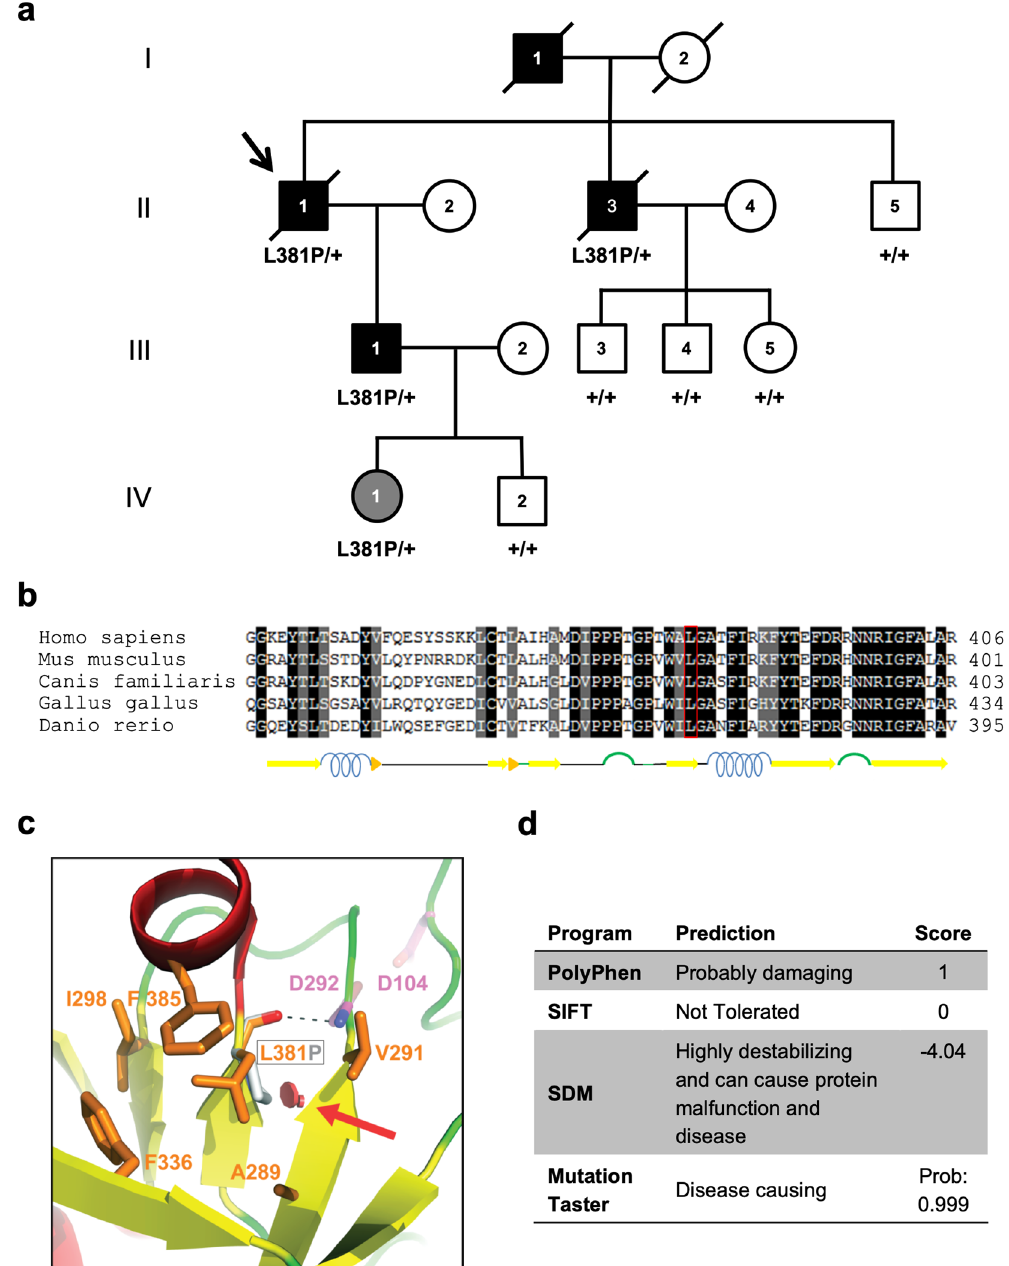
Figure 1. Identification of L381P renin variant in an ADTKD family. ( a ) Pedigree chart of the ADTKD family segregating the renin p.L381P variant. Index case (arrow): II-1. Black symbols denote clinically affected individuals, open symbols denote clinically unaffected individuals. Corresponding REN genotype is provided for each tested individual. ( b ) Alignment of renin sequence from human, mouse, dog, chicken and zebrafish performed with the Sequence Manipulation Suite 38 . Identical or similar residues are shown with a black and grey background respectively. Predicted secondary structure is shown below. ( c ) Detail of the human renin structure, shown in cartoon representation and colored by secondary structure (red: α -helices; yellow: β -strands; green: loops). L381 and nearby conserved hydrophobic residues (orange), as well as the two catalytic aspartates (magenta), are depicted as sticks; a red arrow indicates the steric clash (red discs) that would be introduced upon mutation of L381 to proline (grey stick). The main-chain hydrogen bond between L381 and D292 is represented by a dashed black line. The figure was made with PyMOL (Schrödinger LLC). ( d ) Predicted effect of the renin L381P variant, as assessed by using PolyPhen-2 29 , Sorting Intolerant From Tolerant (SIFT) 30 , Site Directed Mutator (SDM) 31 and Mutation Taster 32